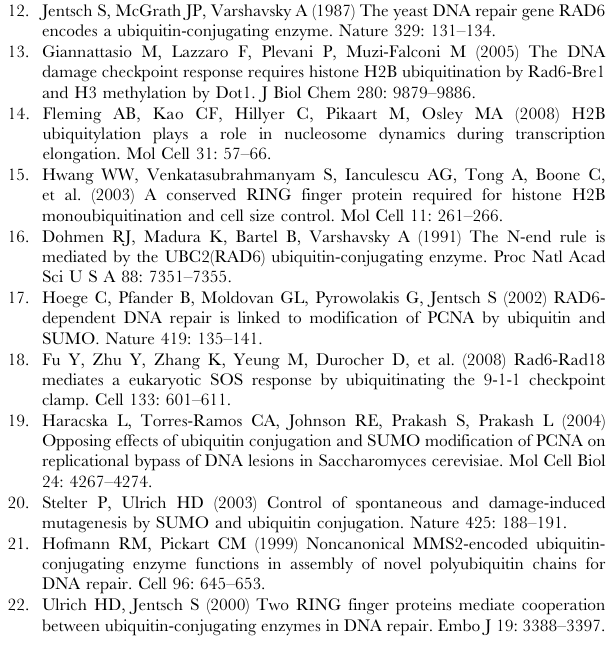
Table S1 Recovery of hygromycin resistant GCRs. Table S2 Yeast